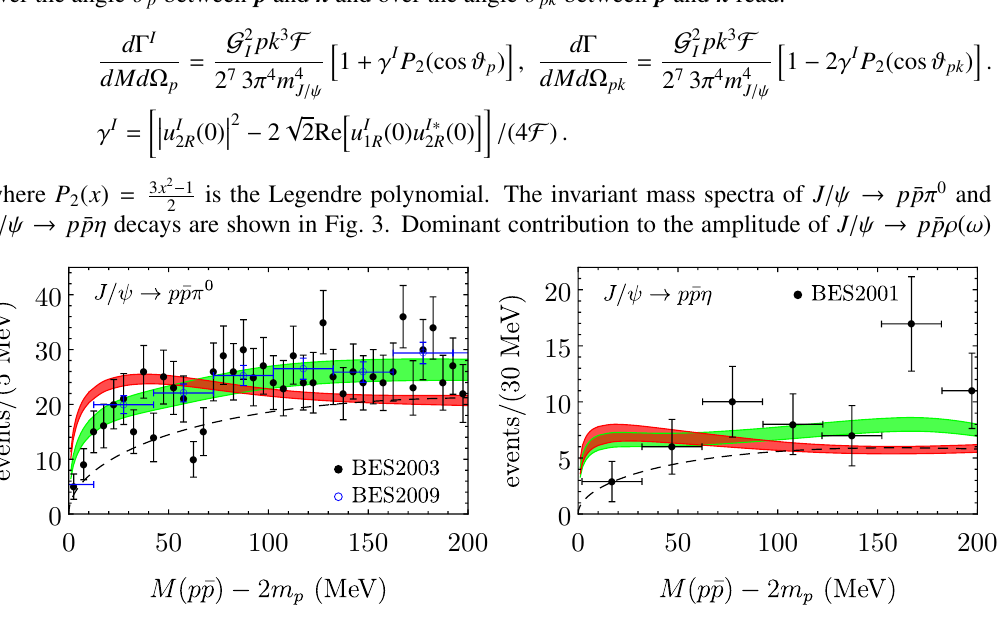
Figure 3. Left picture: J /ψ → p ¯ p π 0 decay; right picture: J /ψ → p ¯ p η decay. The red band corresponds to our previous parameters of the potential and the green band corresponds to the refitted model. The phase space behavior is shown by the dashed